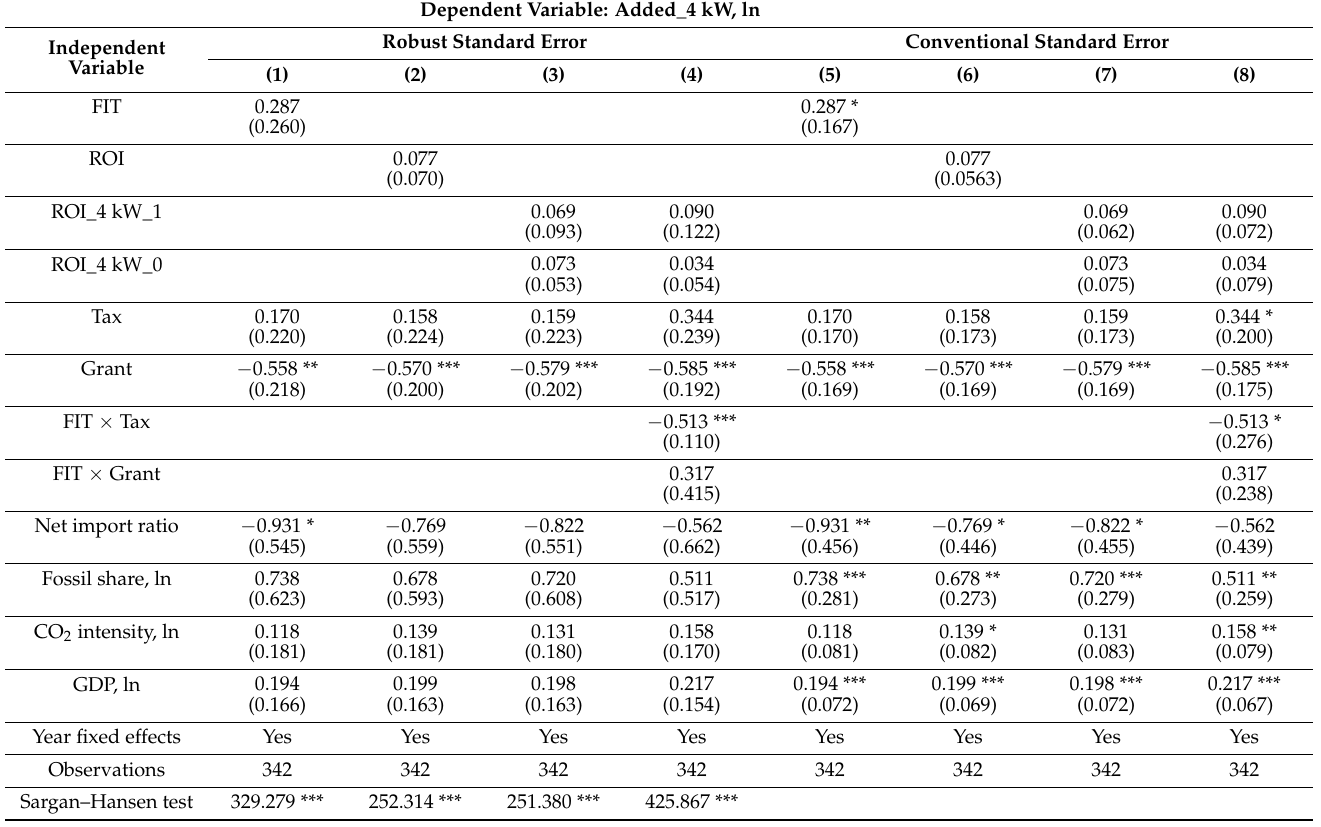
Table A3. Random effects estimation results for solar PV on the residential scales.